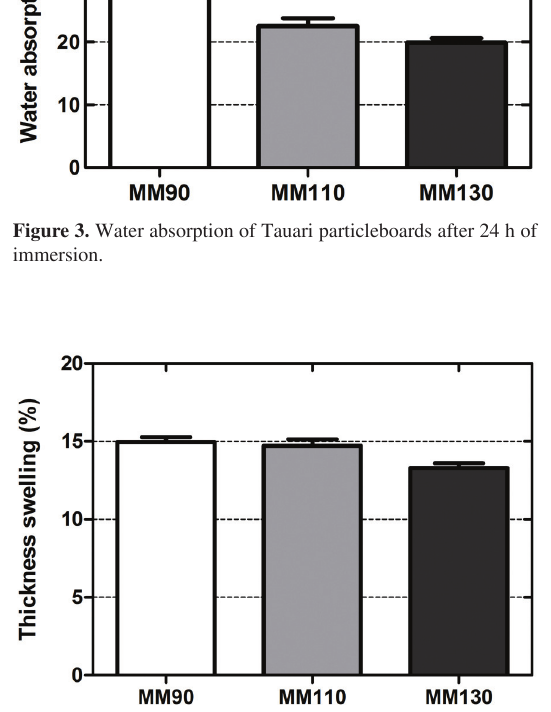
Figure 4. Thickness swelling of Tauari particleboards after 24 h of